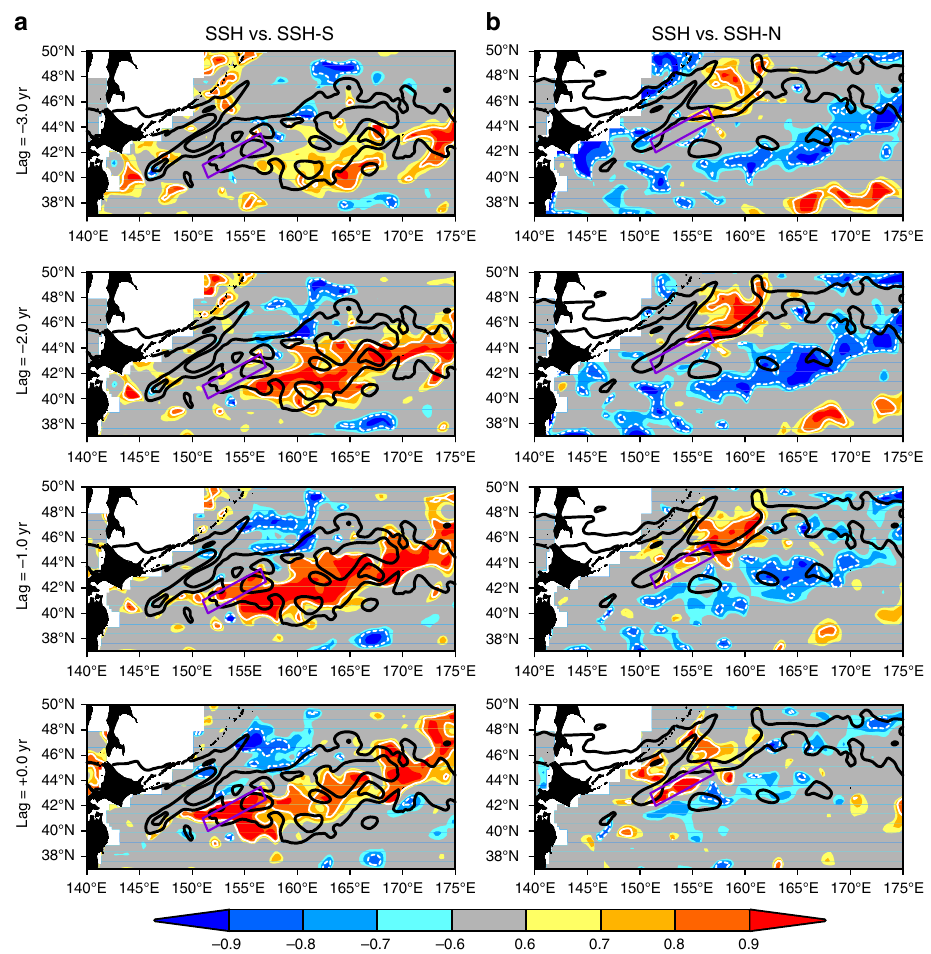
Fig. 3 Propagation of low-frequency signals of the subtropical origin and the subpolar origin. Lag correlation map between low-pass fi ltered (>7 years) SSH anomaly from satellite 45 and normalized SSH time series in the a southeastern box (SSH-S), and b the northwestern box (SSH-N). The southeastern box is indicated by a purple box in a , while the northwestern box is in b . Lag = 0.0 year denotes the simultaneous correlation. Lag = − 3.0 year in a denotes that the SSH anomaly leads the SSH-S time series by 3 years. White contours denote signi fi cance level greater than 95%. Black contours represent the characteristic curves Q c given by Eq. (2) with a 4.5 and 8 × 10 − 6 s − 1 , and b 8 and 12 × 10 − 6 s −